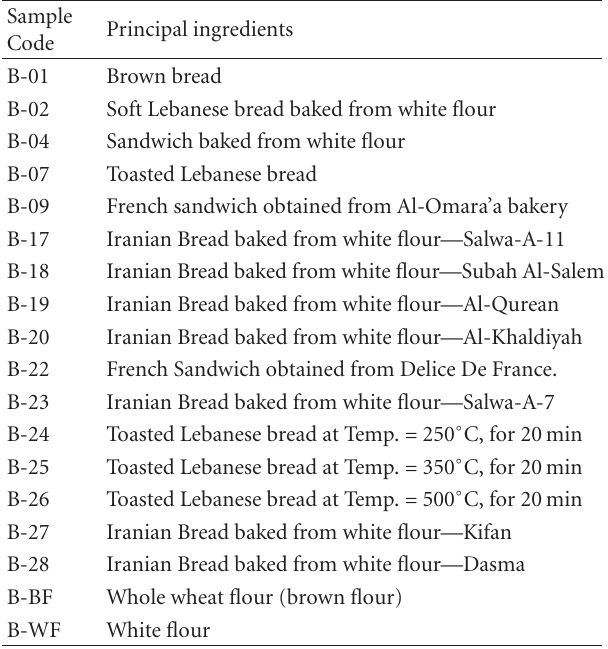
Table 1: Commercial toasting breads and flours samples. Sample